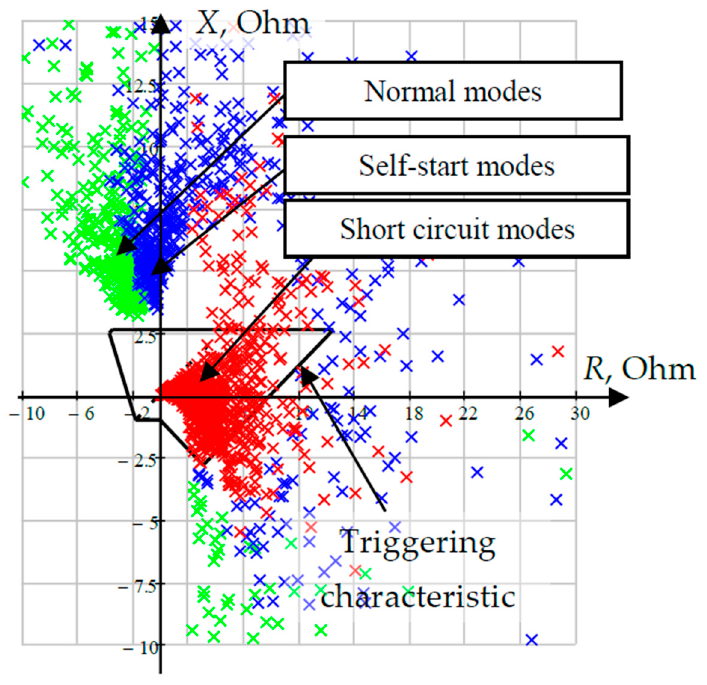
Figure 4. Many complex measurements of resistance in the analyzed modes [26].